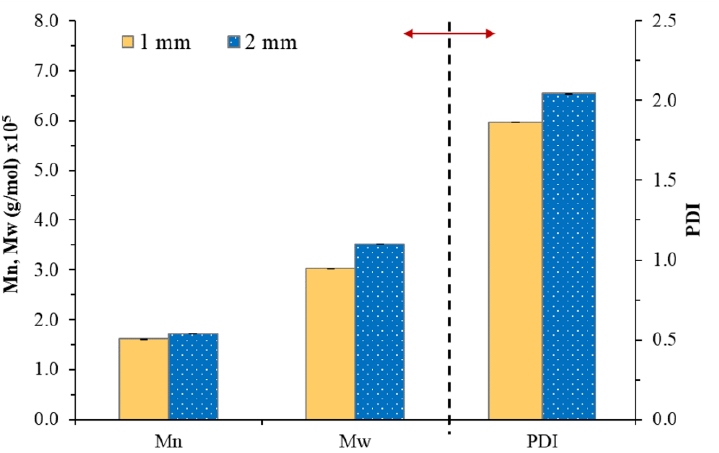
Figure 2. The Mw, Mn and polydispersity index (PDI) of NR obtained from NR-PSA/CO with 20 phr of XG + 0.06 phr of CO with a mastication time of 10 min for different nip gaps (1 and 2 mm).